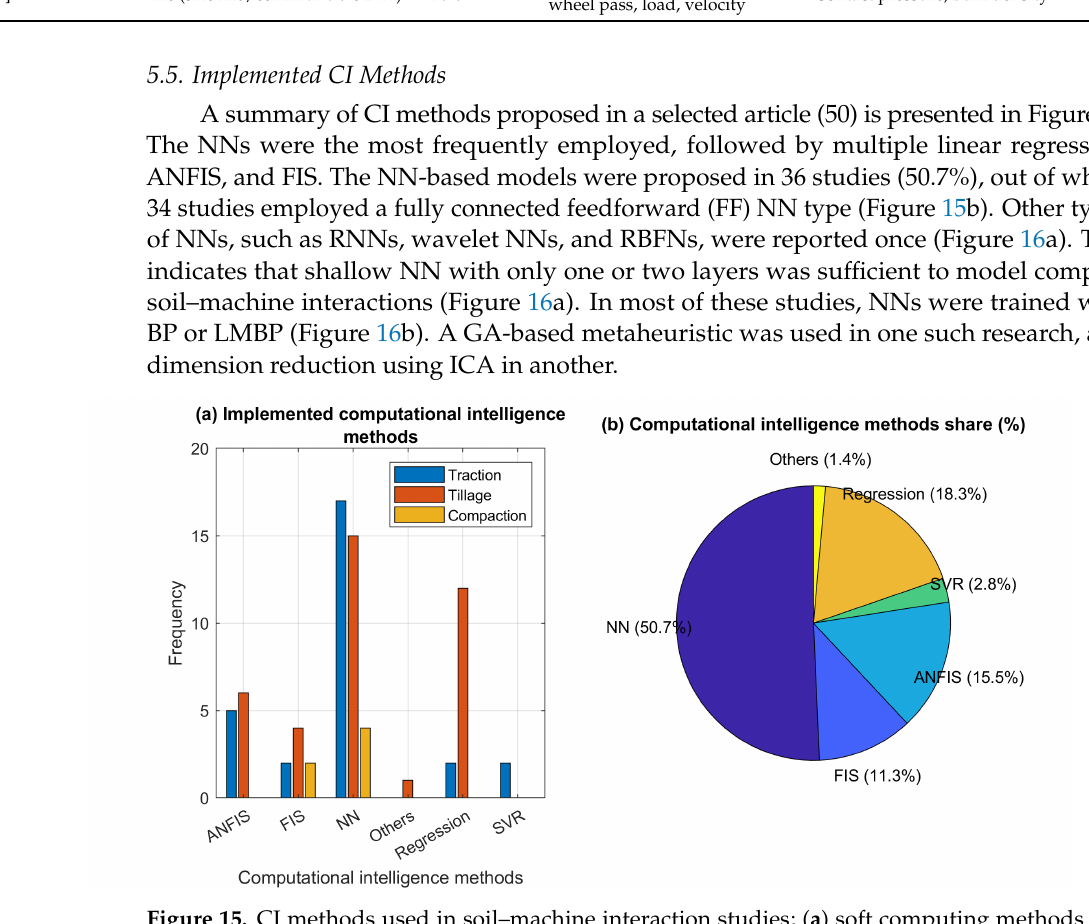
Figure 15. CI methods used in soil–machine interaction studies; ( a ) soft computing methods and their frequency; ( b ) percentage share of each